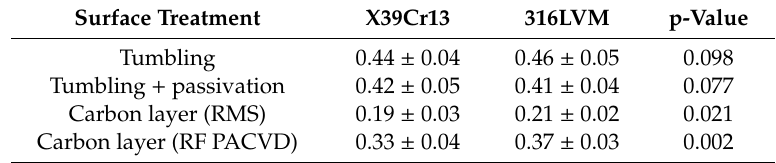
Table 3. Results of comparative surface roughness, R a [ µ m], of the analyzed materials.